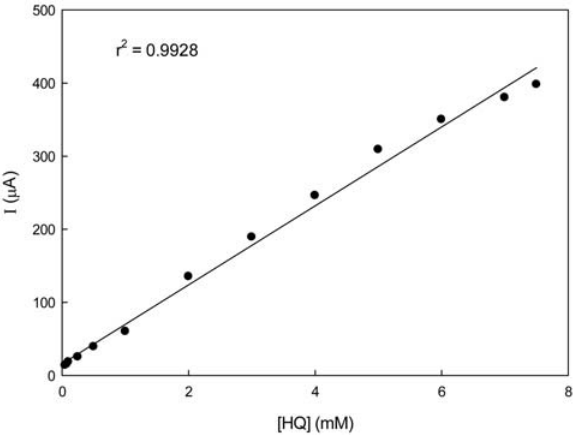
Figure 9. Linear behavior of anodic peak current as a function of concentration for electro-oxidation response of HQ in a phosphate buffer solution (pH 5.0) at Pt/PAAQ-SDS modified